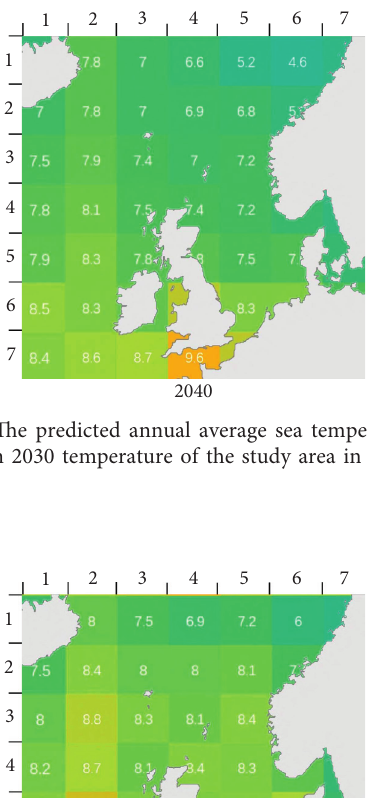
Figure 17: Predicted migration positions of herring and mackerel: (a) herring migration illustration and (b) mackerel migration